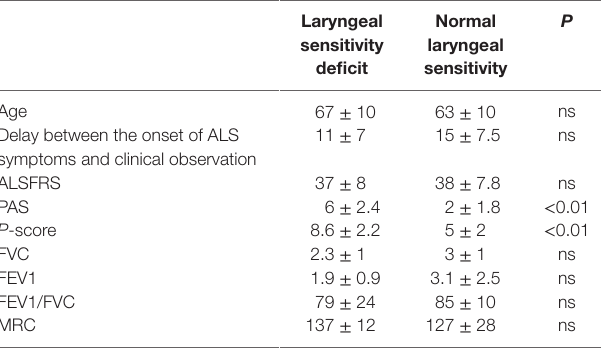
TaBle 4 | clinical and instrumental variables in the two groups, with normal laryngeal sensitivity and laryngeal sensory